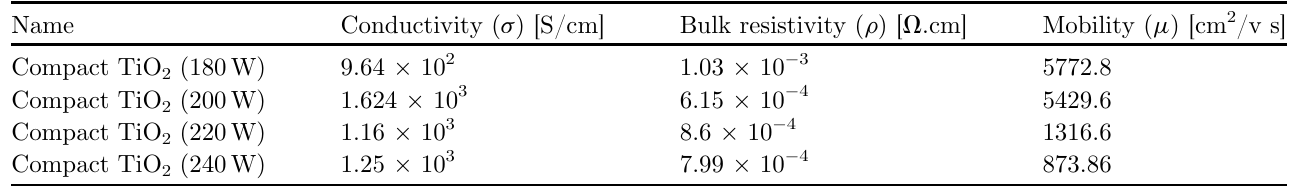
Table 2. Electrical properties of the compact TiO Pauw four-probe method.